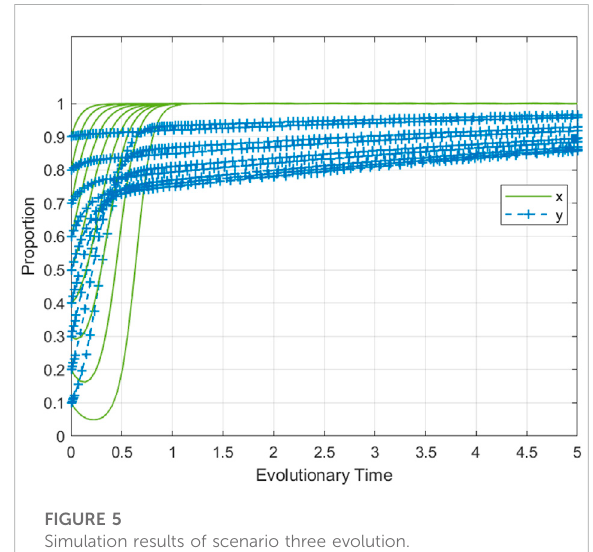
FIGURE 5 Simulation results of scenario three